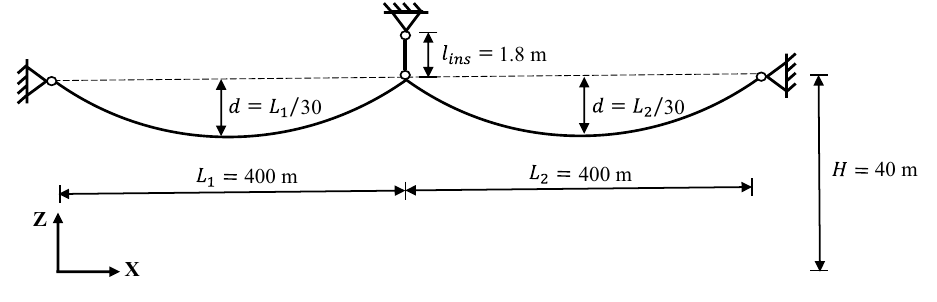
Figure 8. Sketch of the two-span TL section model (not to scale).